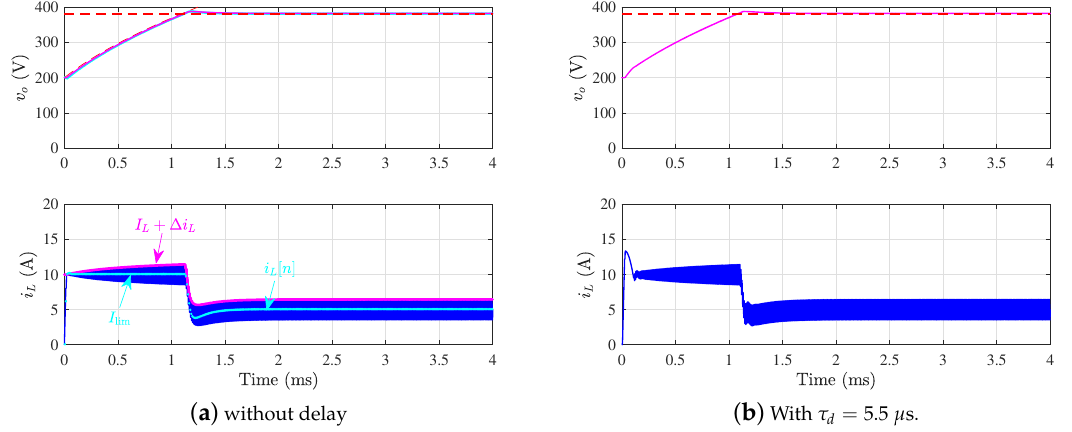
Figure 12. Startup and steady-state response from numerical simulations using a detailed switched model implemented in PSIM c (cid:13) and the discrete-time